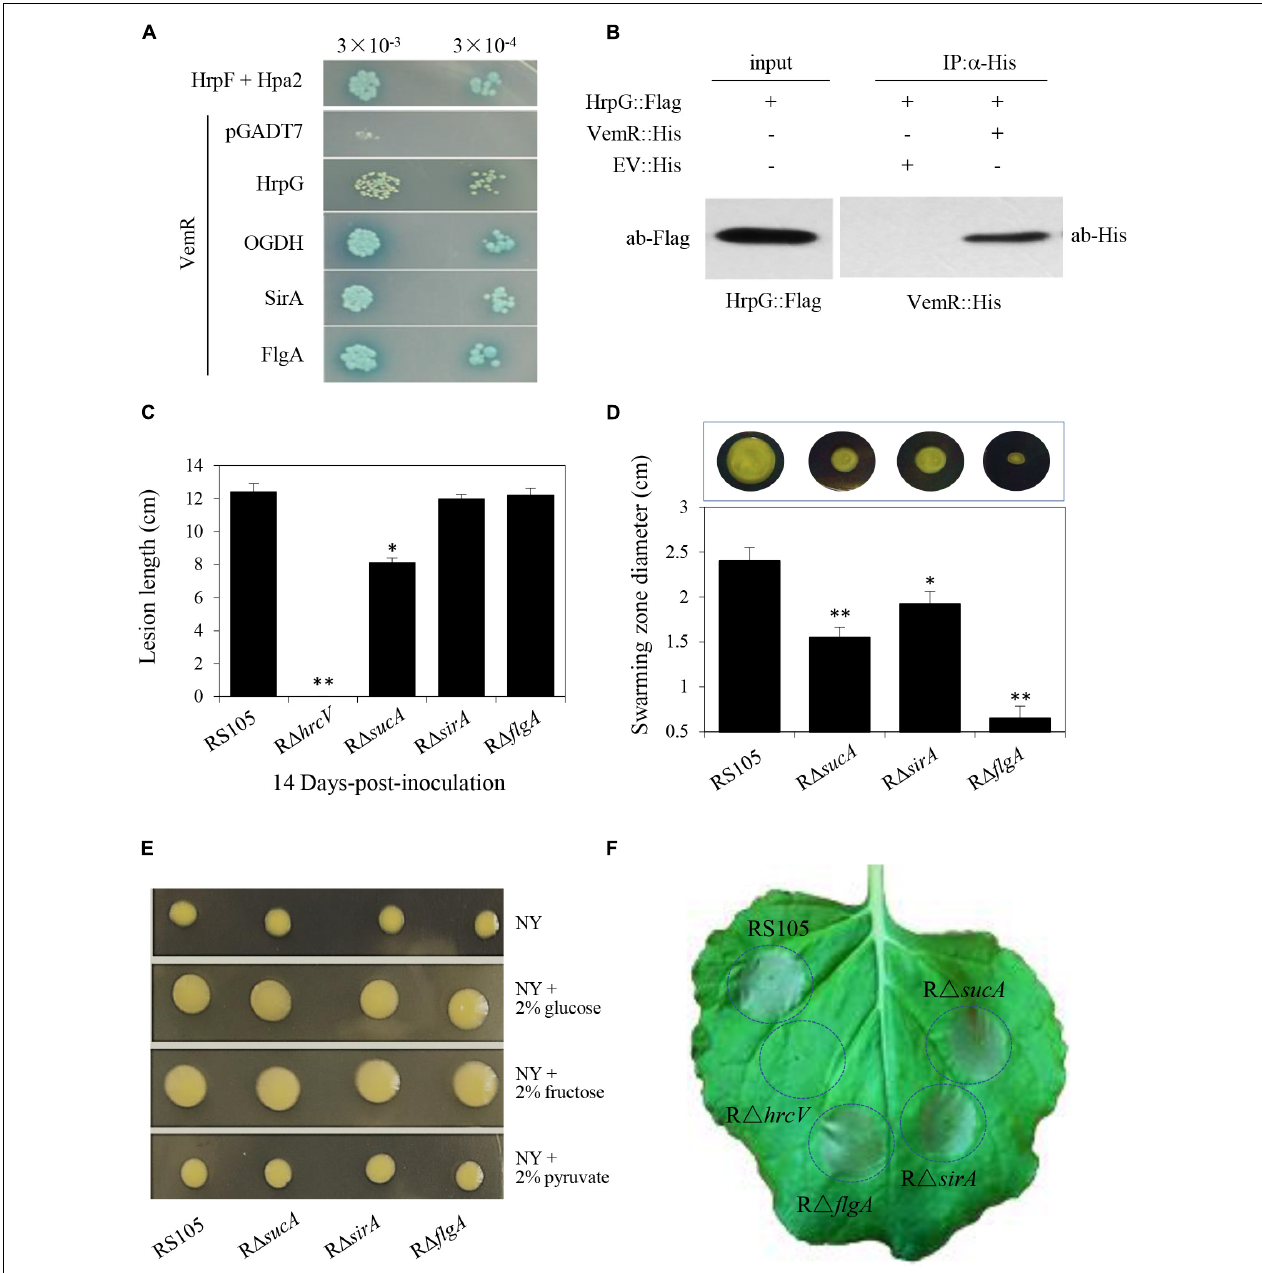
FIGURE 6 | VemR interactions with multiple signaling partners differentially affect pathogenicity traits of X. oryzae pv. oryzicola ( Xoc ). (A) Interactions of VemR with HrpG, OGDH, SirA, and FlgA were confirmed by yeast two-hybrid and β -gal assays. Yeast Y2H Gold cells (strain AH109) were co-transformed with pGBKT7-derived “bait” and pGADT7-derived “prey” vectors expressing VemR fused with the GAL4 DNA binding domain (BD) and test proteins fused with the GAL4 activation domain (AD), respectively. Serial dilutions of the selected transformants were plated on QDO (Quadruple dropout; SD/-Leu/-Trp/-Ade/-His) plates with and without X- α -Gal and incubated at 28 ◦ C for 3 days. Co-expression of pB- hpa2 /pA- hrpF and pB- vemR /pGADT7 represent positive and negative controls, respectively. (B) Co-immunoprecipitation analysis showing VemR interactions with HrpG. Samples before (input) and after (IP: α -His) immunopurification were analyzed by immunoblotting using anti-Flag and anti-His antibodies. (C) Bacterial leaf streak lesions on rice leave caused by Xoc deletion mutant strains R ρ sucA , R ρ sirA , R ρ flgA , and R ρ hrcV (T3SS-deficient strain, used as the negative control) 14 days-post-inoculation (dpi). (D) Swarming motility of Xoc strains R ρ sucA , R ρ sirA , R ρ flgA on NY medium containing 0.5% glucose. The data were scored 2 days after-inoculation. (E) Colony morphology of Xoc strains R ρ sucA , R ρ sirA , R ρ flgA as compared to the wild-type RS105 on NY medium with 2% glucose, fructose, or pyruvate. (F) HR induction on non-host tobacco ( N. benthamiana ) leaves by Xoc strains R ρ sucA , R ρ sirA , R ρ flgA , and R ρ hrcV . The experiment was independently repeated three times. The photograph was taken 24 h post-inoculation (hpi) from a representative leaf. Values presented are the mean ± standard deviation (SD) from three independent experiments with five replications each. Student t -test ( p = 0.01 and 0.05) was used to separate significantly different means denoted by ** and *,